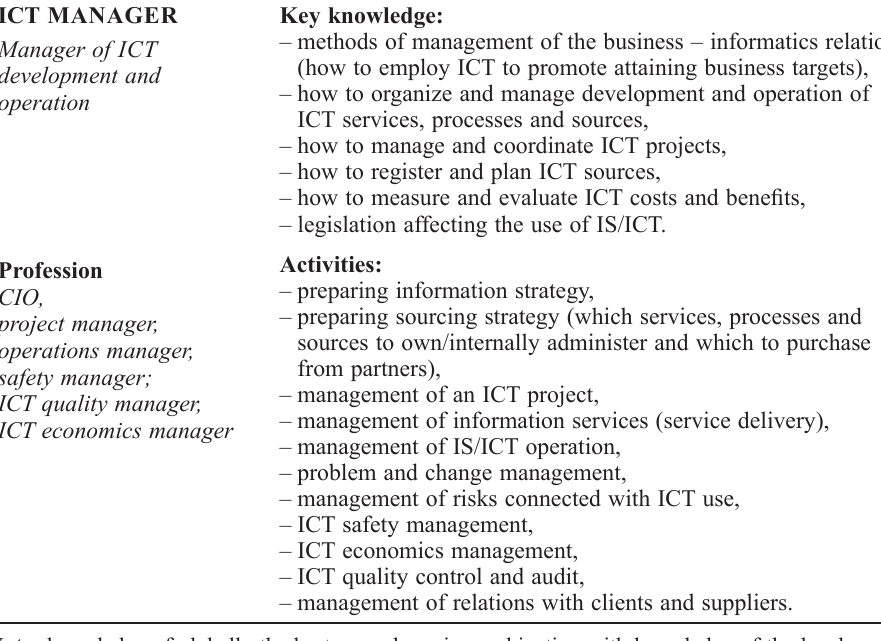
Table 1. Roles of an ICT